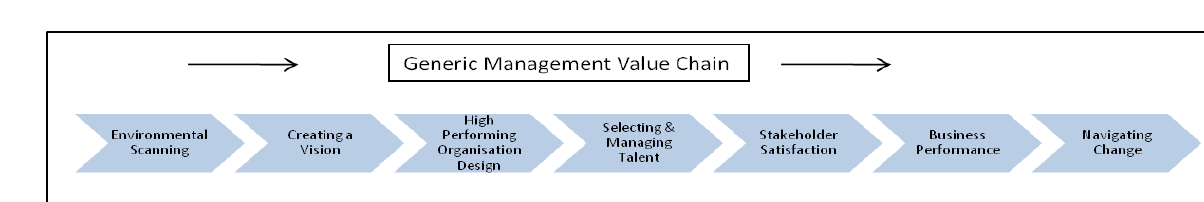
Figure 2 – Proposed Generic Management Value Chain (Adapted from Veldsman & Roodt,